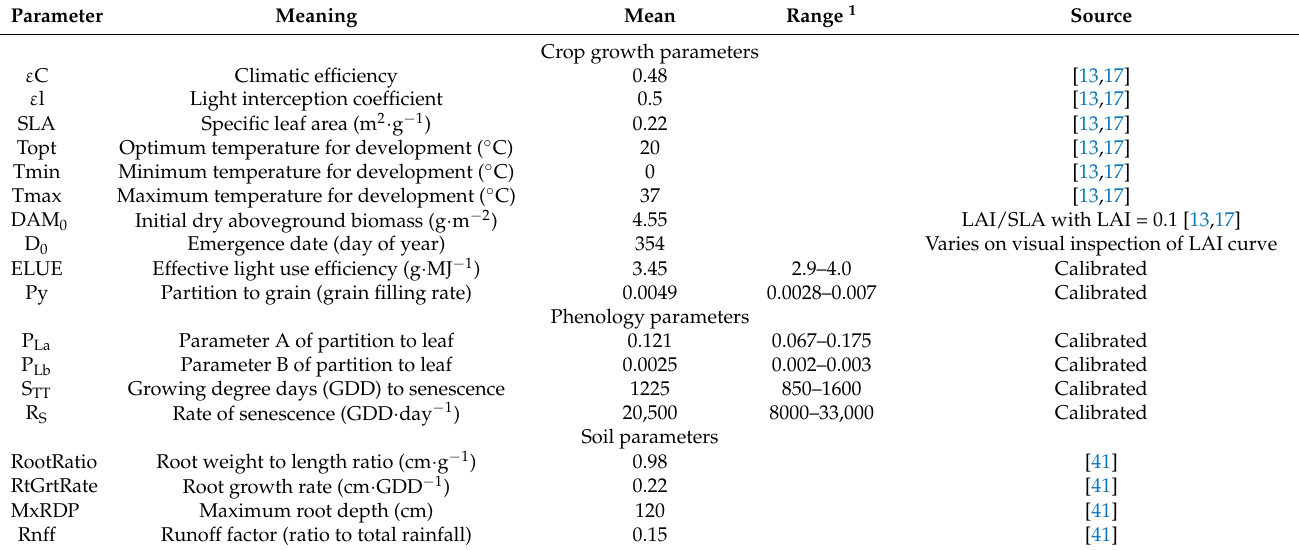
Table 1. List of SAFYsw parameters and values used in the